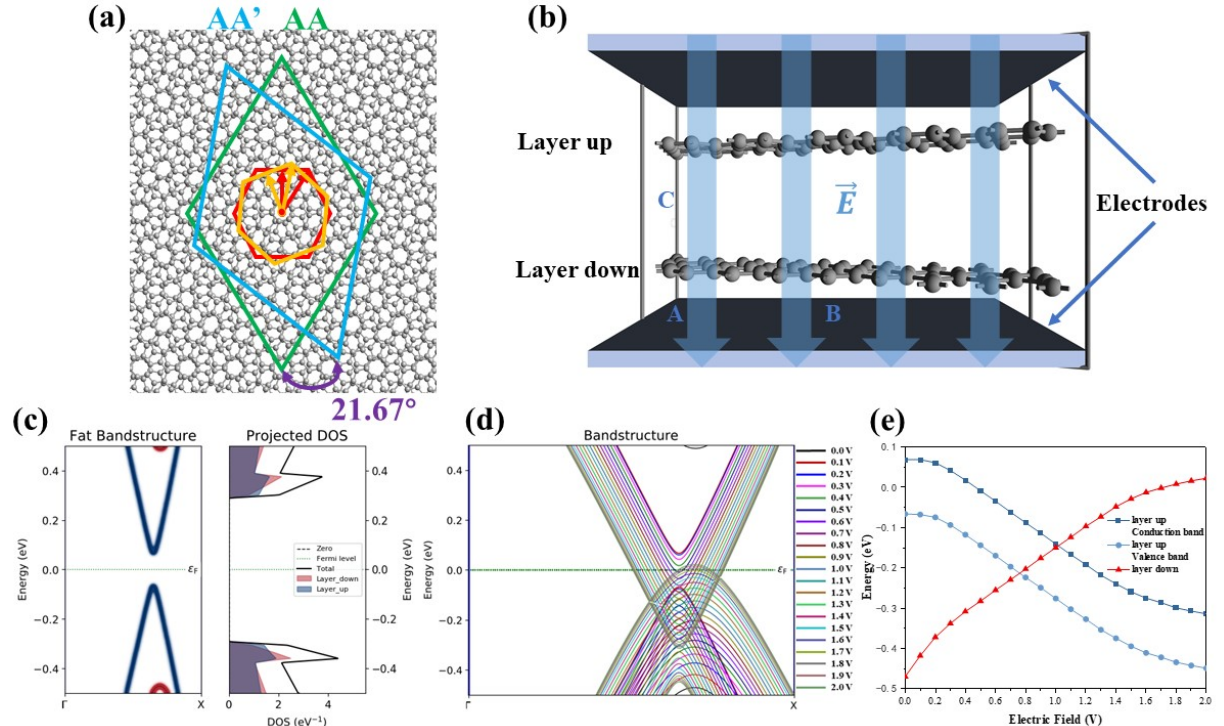
Figure 1. ( a ) Schematic diagram of the relative rotation of the cell and Brillouin zone of the TBG; ( b ) schematic diagram of the simulation of the optical properties of the TBG induced by external electric field; ( c ) diagram of the fat band structure and projected density of states of the TBG; ( d ) diagram of the band structures of the TBG tuned by electric field; ( e ) the band structure variations of the TBG with different electric